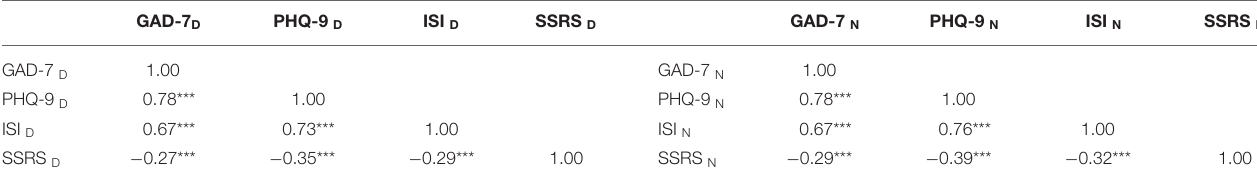
TABLE 4 | The partial correlation of each scale of non-first-line doctors and nurses.